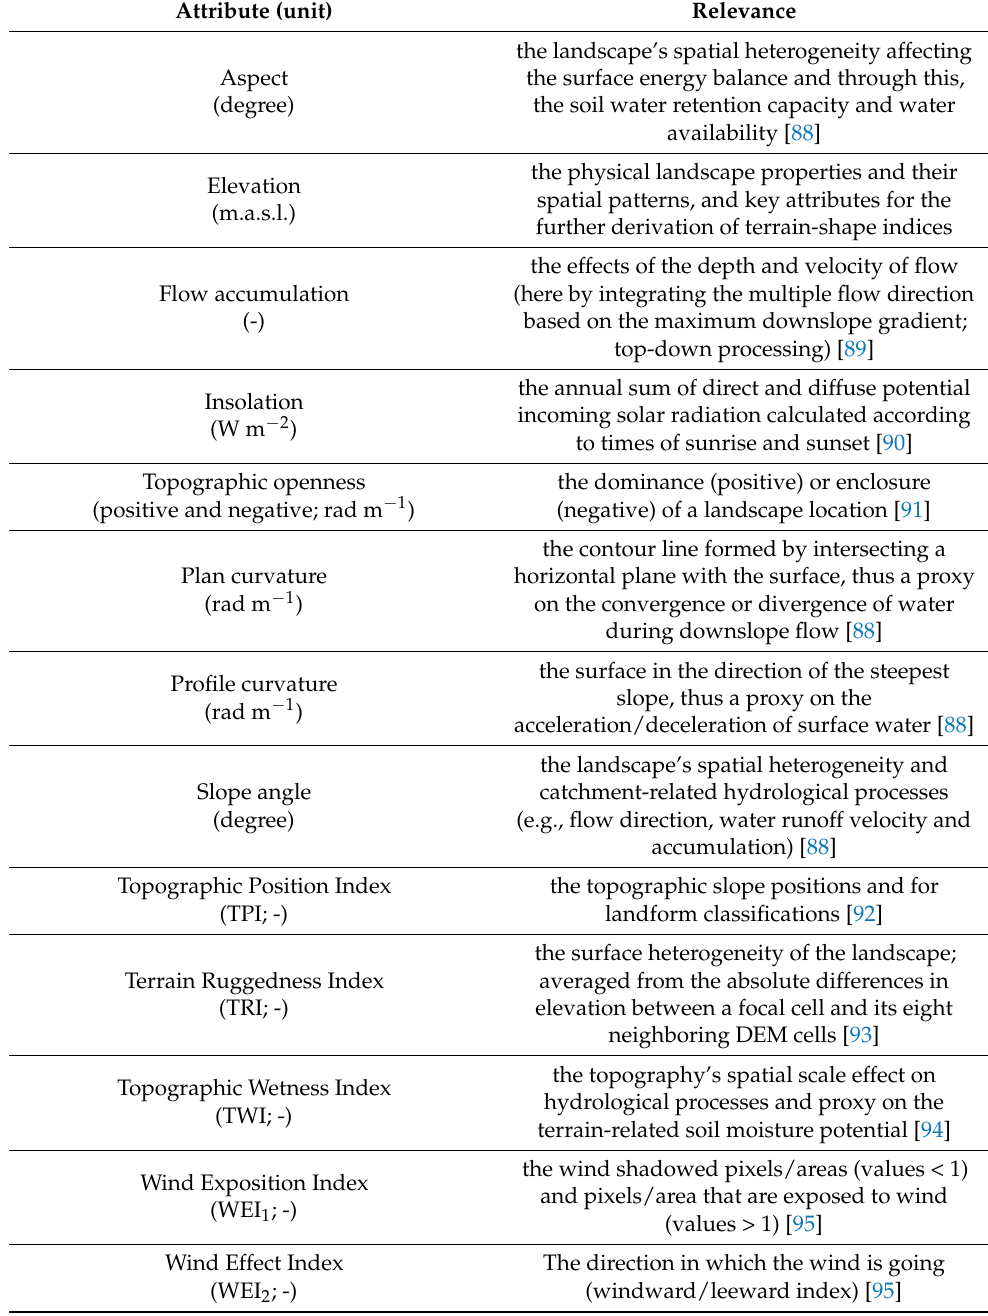
Table 2. Topographic attributes calculated in SAGA GIS and their relevance as predictors used in the Random Forest classification model for mapping the biological soil crusts in the study